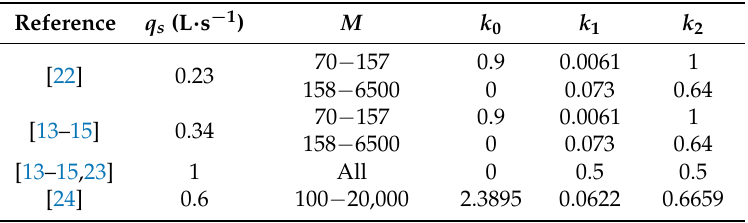
Table 3. Regression constants for the design flow rates in drainage